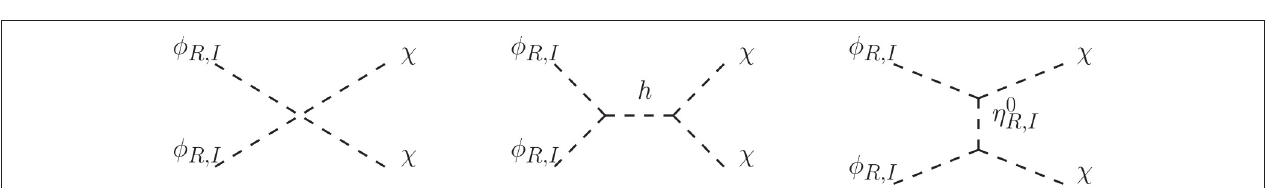
FIGURE 3 | The diagrams for the standard annihilation processes.